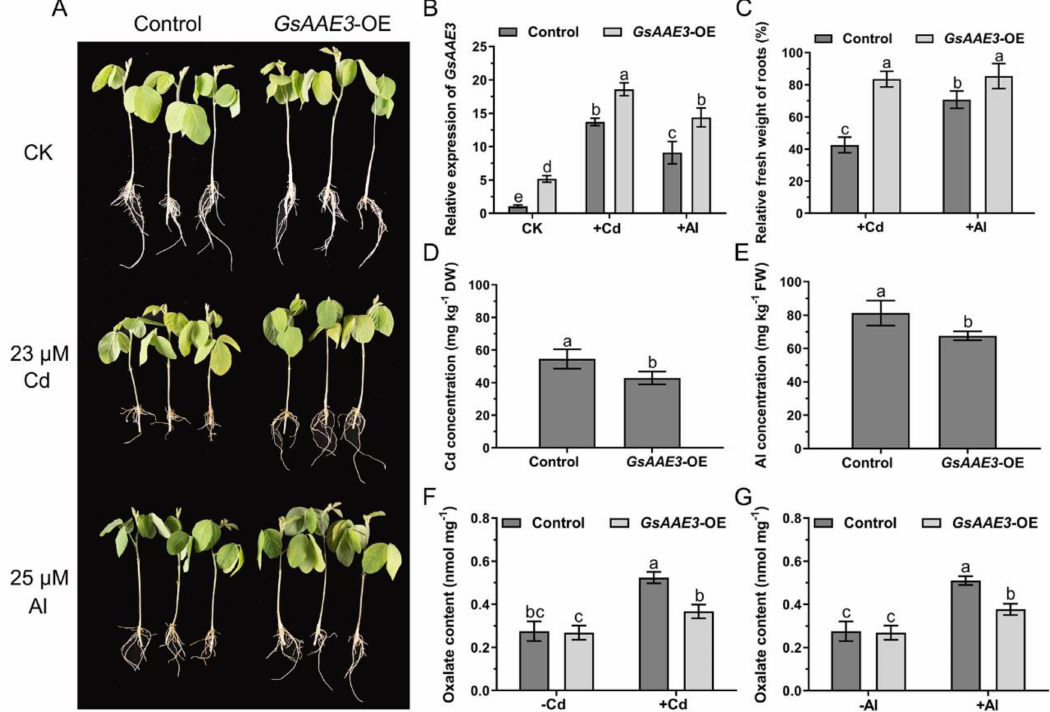
Figure 7. Performance of GsAAE3 transgenic hairy roots under Cd and Al stresses. ( A ) Cd and Al tolerance phenotypes of overexpressing GsAAE3 in soybean hairy roots. ( B ) Relative expression of GsAAE3 in transgenic and control hairy roots under Cd and Al stresses and blank. ( C ) Relative fresh weight of hairy roots in transgenic and control plants under Cd and Al stresses. ( D , E ) The e ff ect of Cd and Al stresses on Cd and Al concentrations in control and transgenic soybean hairy